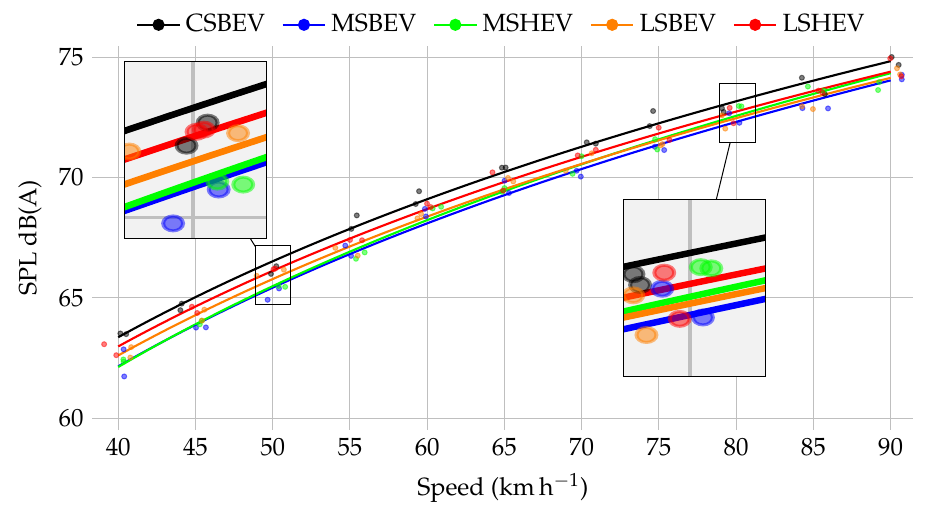
Figure 14. Air temperature corrected rolling SPL regression curves compared on five different vehicles for 255B on the left